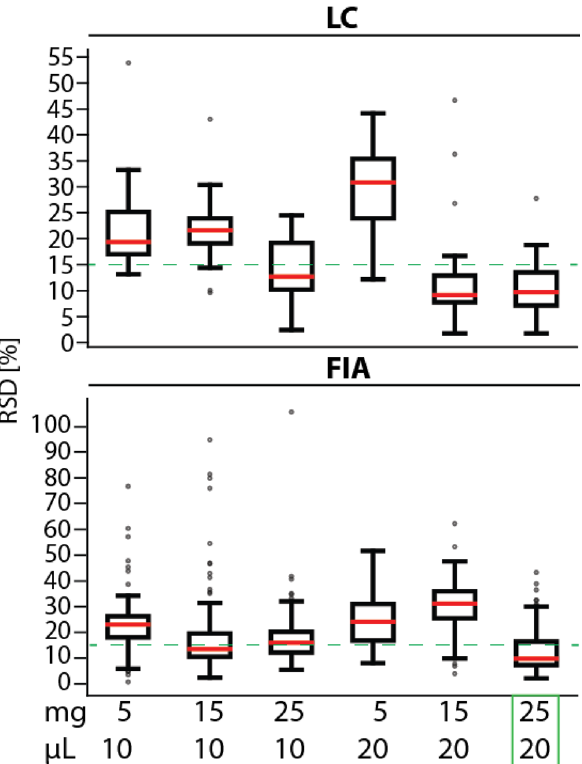
Figure 1. Boxplots of individual compounds’ relative standard deviation (RSD) using different cell masses (mg) and loading volumes (µL). Dashed line represents the quality assurance threshold of 15%. Five replicates were measured in each condition; outliers were removed from the final analysis as described in the materials and methods. Highlighted in green is the combination we consider the best. LC: liquid chromatography. FIA: flow injection